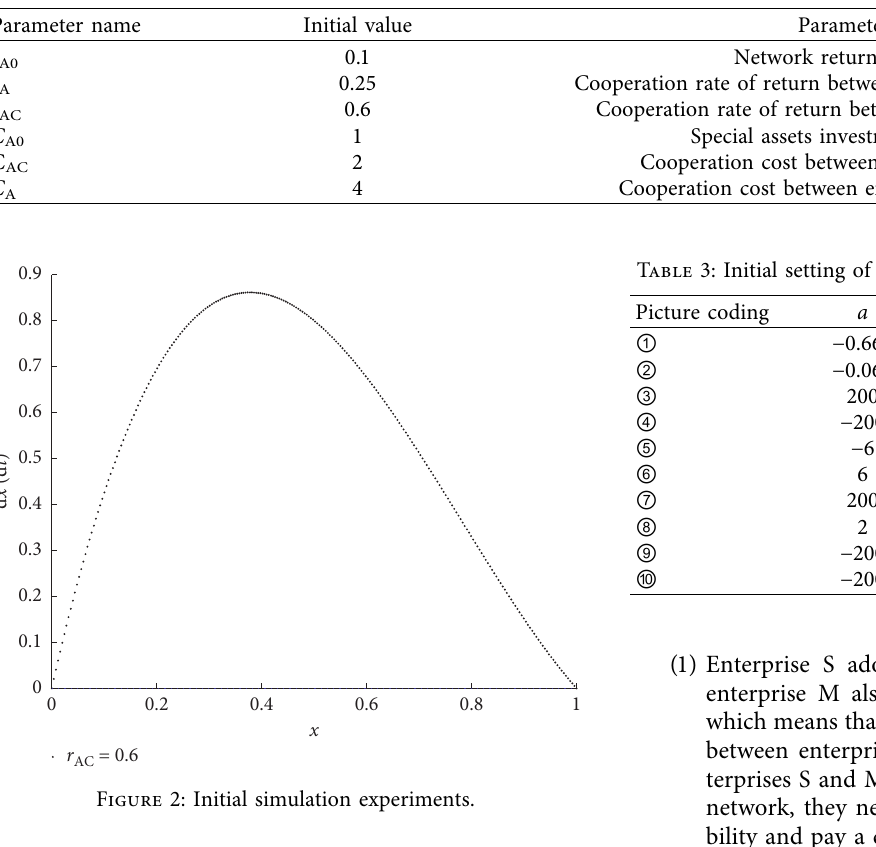
Table 2: Initial values of parameters and implications.